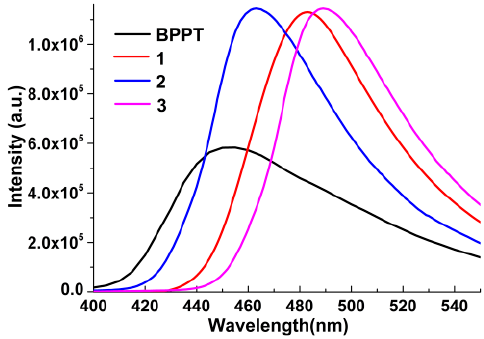
Figure 7. The emission spectra of BPPT, 1 , 2 , and 3 in the solid state at room temperature.